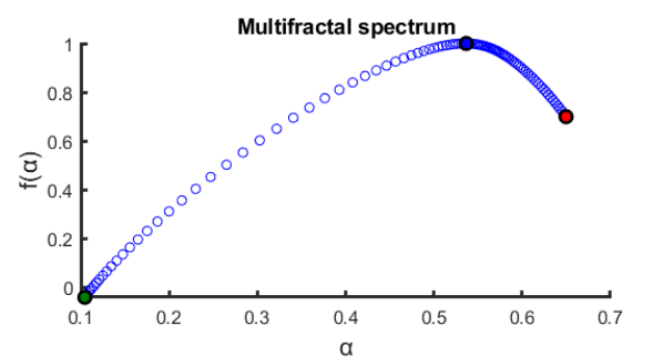
Figure 6. The multifractal spectrum f ( α ) versus α